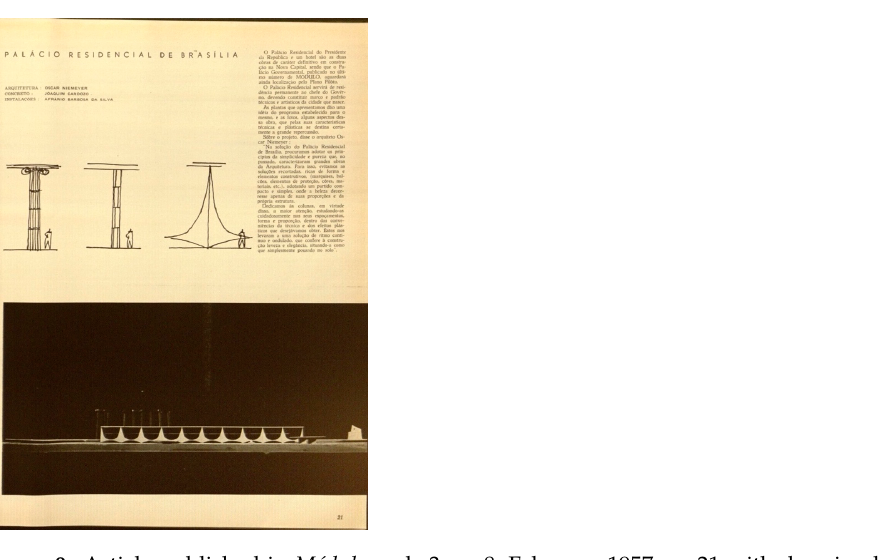
Figure 9. Article published in Módulo , vol. 3, n. 8, February 1957, p. 21 with drawing by Oscar Nie- meyer and architectural model of the Palácio da Alvorada, courtesy of Arquivo Público do Distrito Federal.